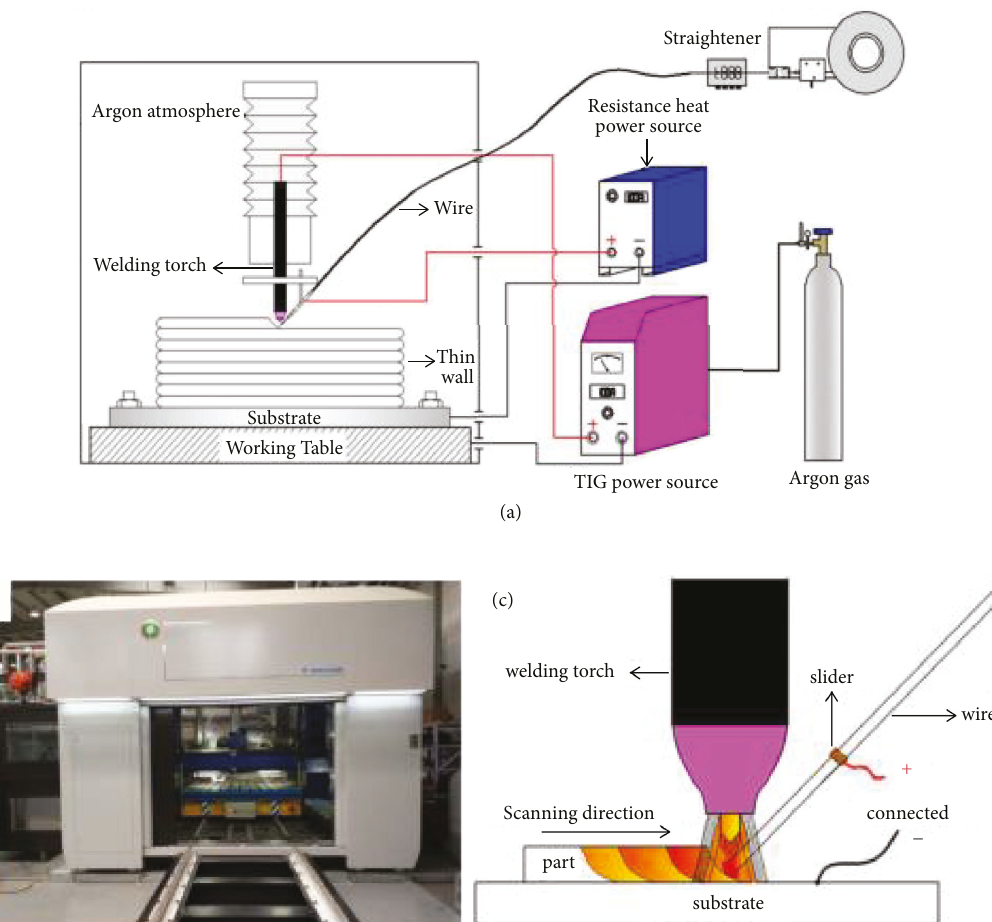
Figure 2: (a) Schematic of the hot-wire arc additive manufacturing system. (b) Overview of the hot-wire arc additive manufacturing system. (c) Schematic principle to procedure the resistance